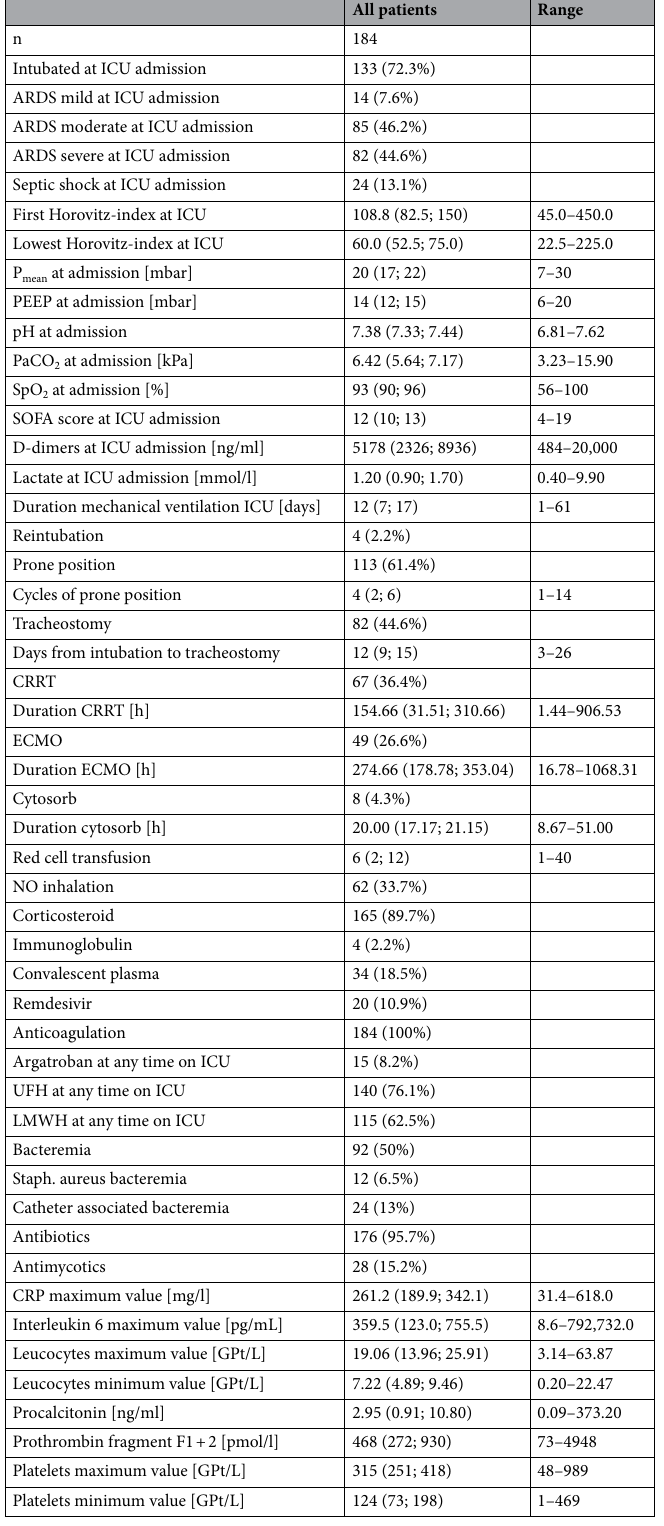
Table 1. ICU baseline characteristics during ICU stay. Data are median (Interquartile range) or n (%). ICU Intensive care unit, ARDS Acute respiratory distress syndrome, P mean Mean pressure, PEEP Positive